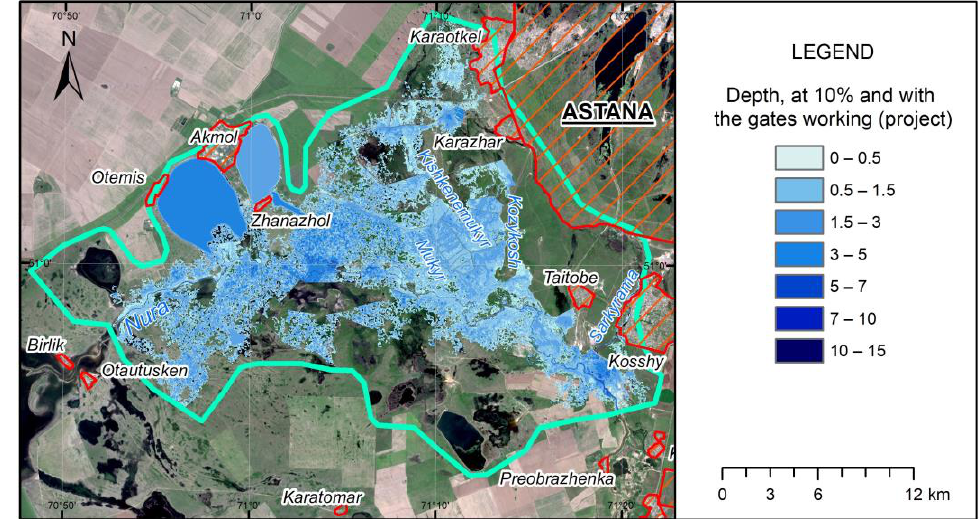
Figure 14. Maximum flood depth map of the 2019 flood hydrograph simulated on modified DEM .